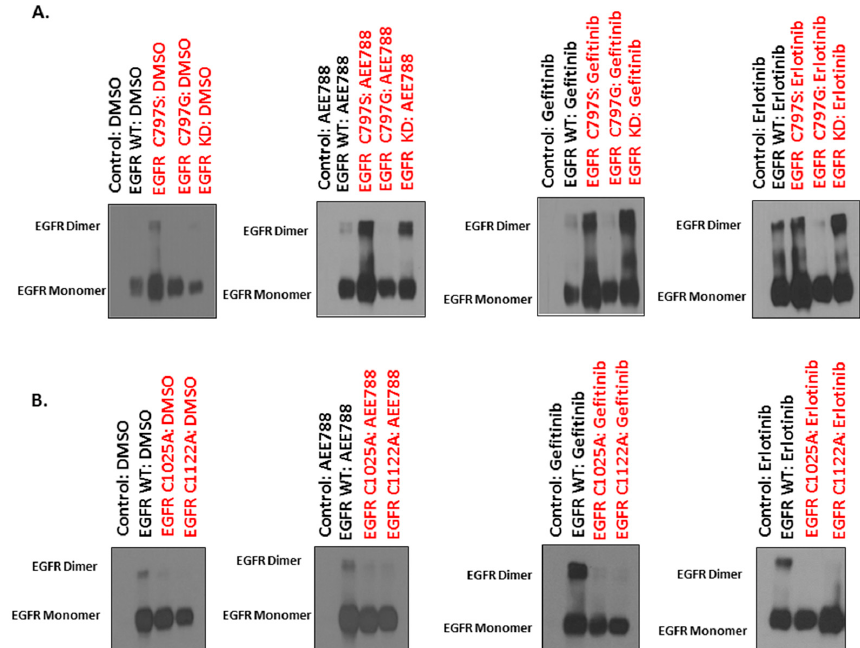
Figure 4. Mutations of palmitoylated cysteine in the kinase domain and C-terminal tail of EGFR blocks TKI-induced receptor dimerization. Upper panel: ( A ) HEK293 cells were transfected with negative control (no plasmid), and 100 ng of wt-EGFR, EGFR cysteine mutants (C797S and C797G) and EGFR kinase-dead (EGFR KD) mutant using polyethylene immine (PEI), respectively. Following 24 h post-transfection, the cells were treated with either DMSO or TKIs (AEE788, gefitinib, and erlotinib) at a concentration of 5 µ M for 24 h in serum-free conditions. Cell lysates were collected in non-reducing conditions and resolved on SDS-PAGE gel followed by Western blot; Lower panel: ( B ) HEK293 cells were transfected with negative control (no plasmid), and 100 ng each of wt-EGFR, C1025A mutant and C1122A mutant EGFR using PEI. Following 24 h post-transfection, the cells were treated with either DMSO or TKIs (AEE788, gefitinib, and erlotinib) at a concentration of 5 µ M for 24 h in serum-free conditions. Cell lysates were collected in non-reducing conditions and resolved on SDS-PAGE gel followed by Western